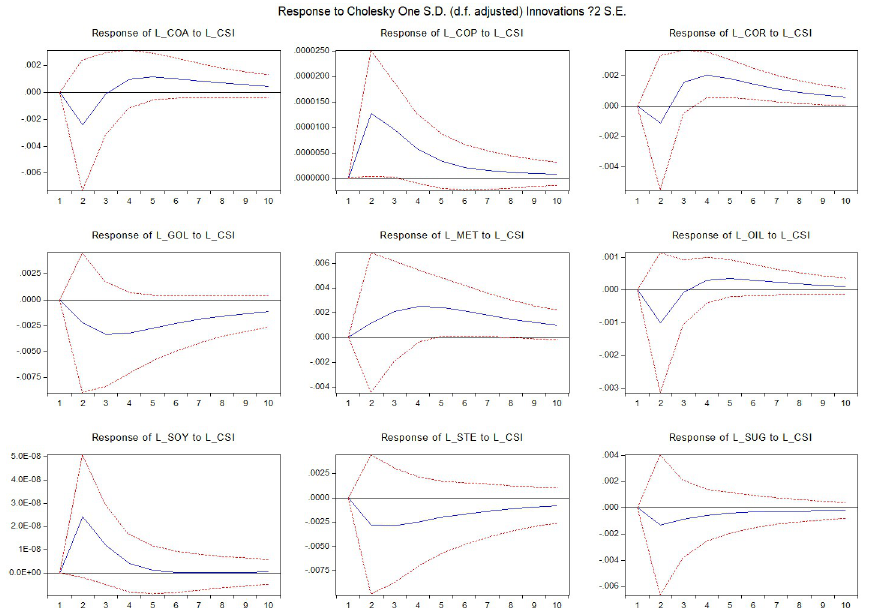
Fig 2. Impulse response functions of market i illiquidity to CSI300 index illiquidity. The figure presents the response of market i illiquidity (i = coa, cor, cop, gol, met, oil, soy, ste, sug) to CSI300 index illiquidity shocks. The sample runs from January 1, 2010 to March 22, 2021. The dotted lines are confidence bands based on Monte Carlo simulated standard errors.